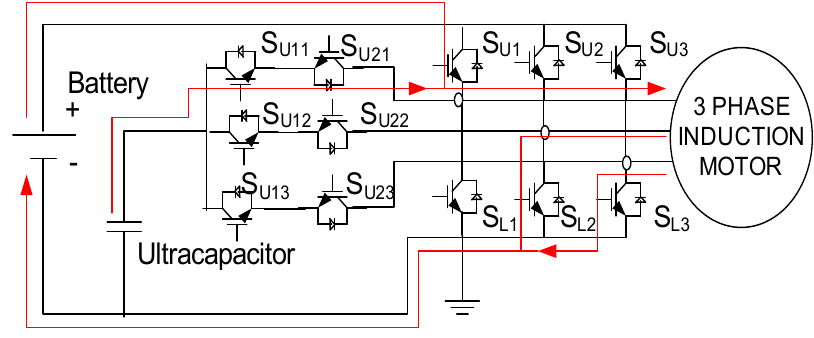
Figure 24. Operation of circuit under mode-1.